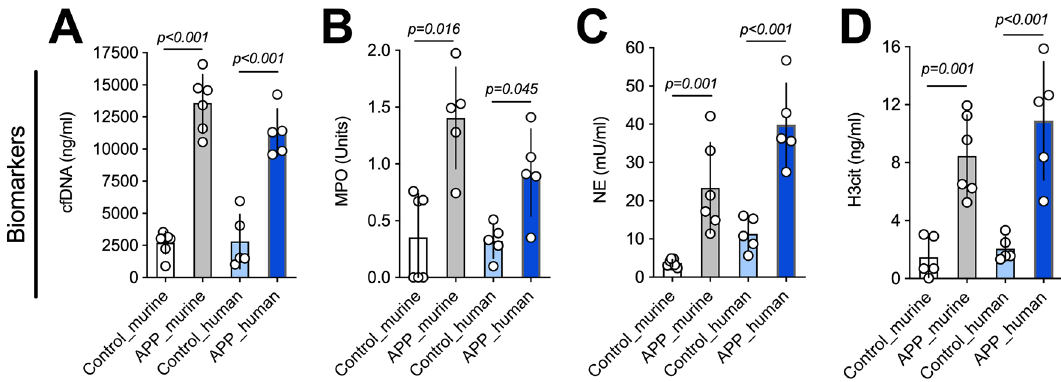
Figure 2. Markers of neutrophil activation and extracellular trap formation are significantly elevated in mice and humans with appendicitis. ( A ) CfDNA, a surrogate marker of NET formation, was significantly elevated in mice and humans with appendicitis. ( B , C ) MPO and NE are markers of neutrophil activation. Both markers were significantly elevated in mice and humans. ( D ) H3cit is the most specific marker of NET formation, and was significantly elevated in mice and humans with appendicitis compared to controls. Data shown as Mean ± SD. Statistics: